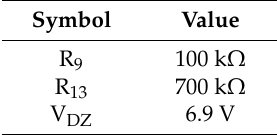
Table 1. Practical values components of the logarithmic amplifier circuit.